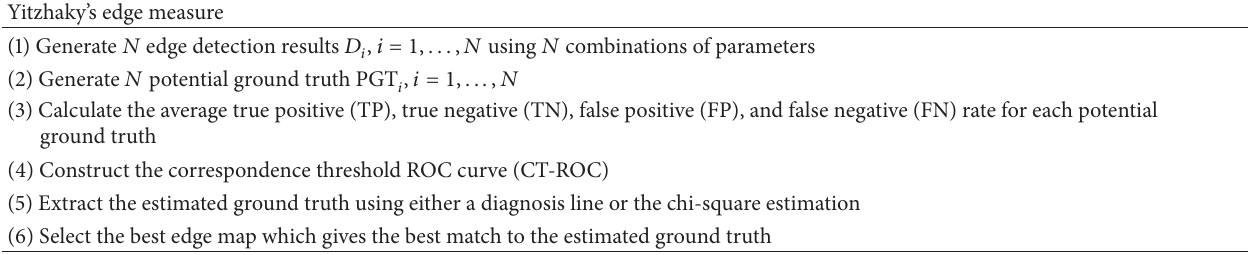
Table 1: Basic steps in Yitzhaky’s NR edge measure.